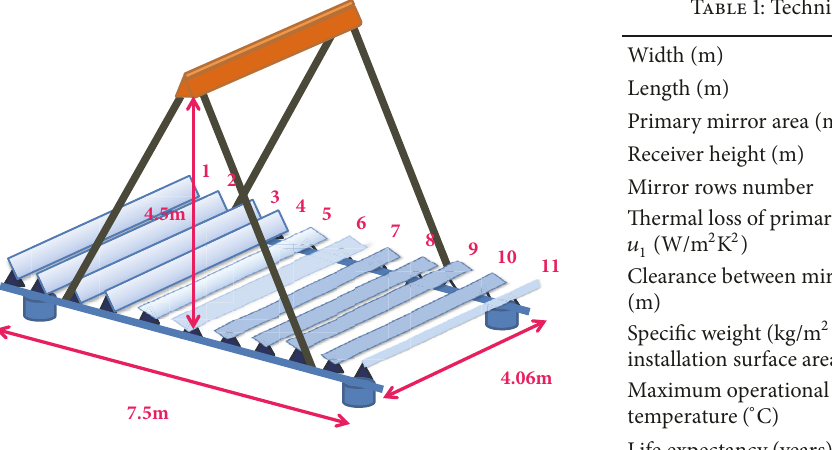
Figure 2: A module of industrial linear Fresnel collector.